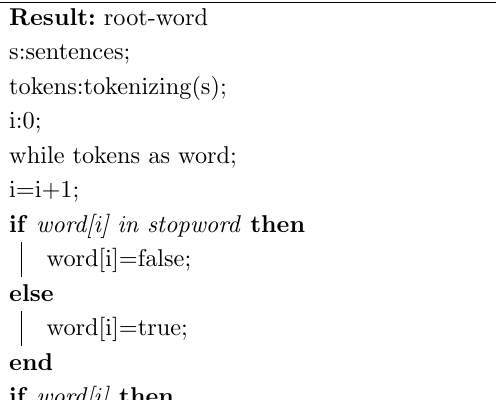
Algorithm 2: The Incorbiz stemming